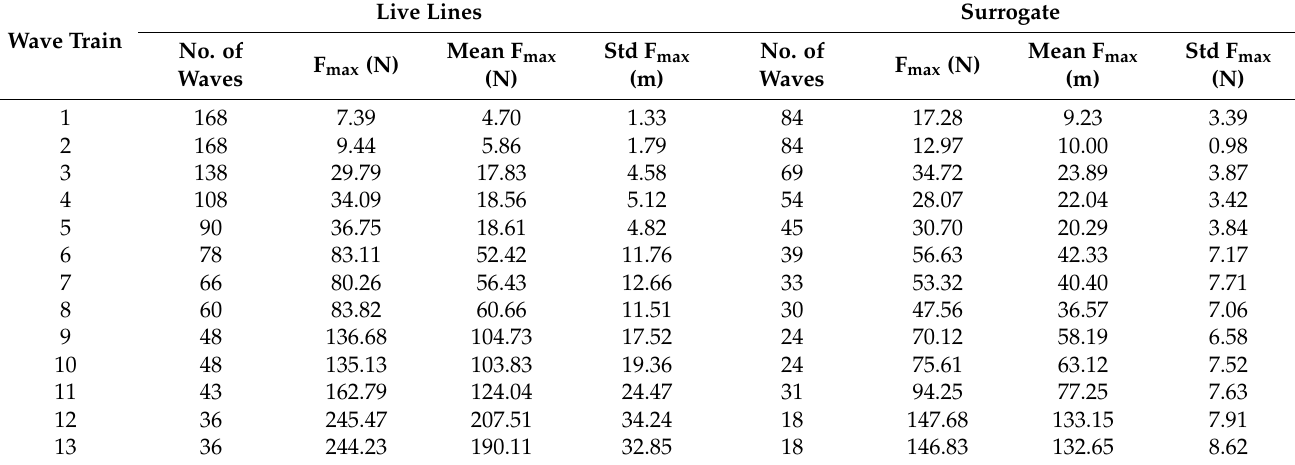
the surrogate underestimates the averaged force peaks of the live lines. The MNE sinks to 22.58% and the RMSE to 48.69% after the averaging approach. Maximum values, as well as standard deviation, are significantly higher for the live lines for higher wave trains. Table 4. Force peaks of total force in x-direction averaged over all live lines and over all runs of the surrogate. Live Lines Wave Train